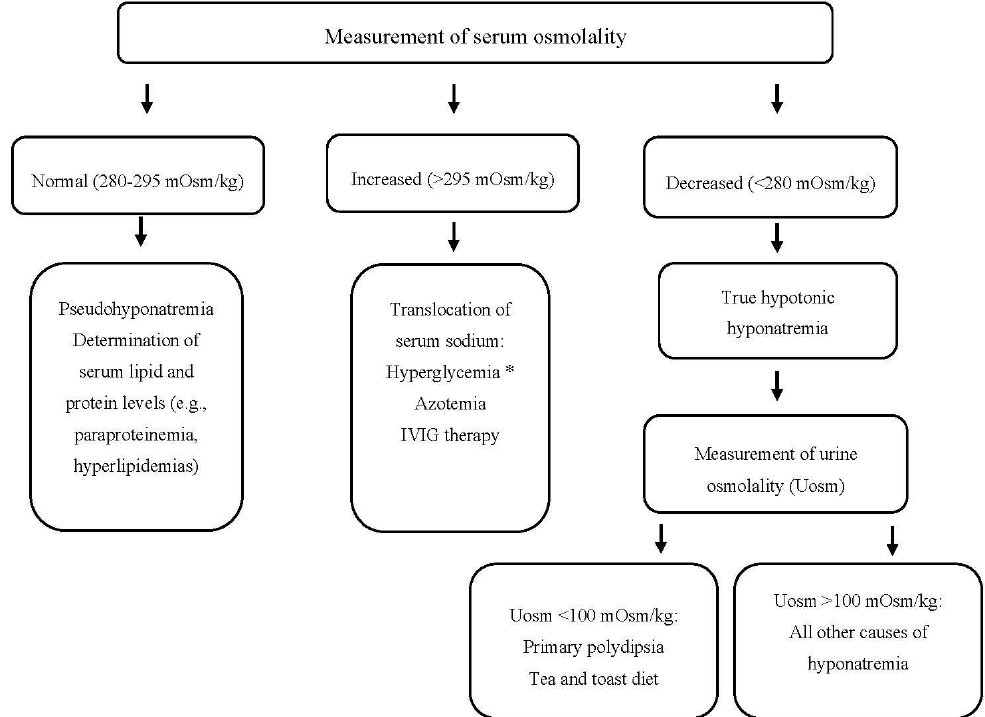
Figure 1. Approach to a patient with hyponatremia (and hematologic disease). * Serum sodium should be corrected for the degree of hyperglycemia. IVIG: Intravenous Immunoglobulin, mOsm: milliosmole, Uosm: urine osmolality.